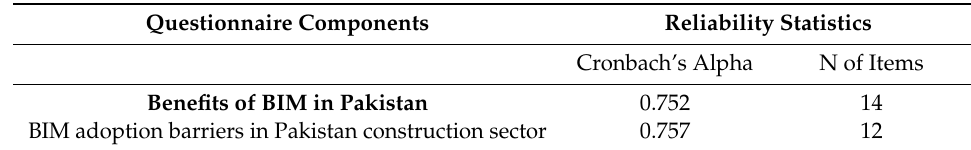
Table 2. Cronbach’s alpha reliability test.